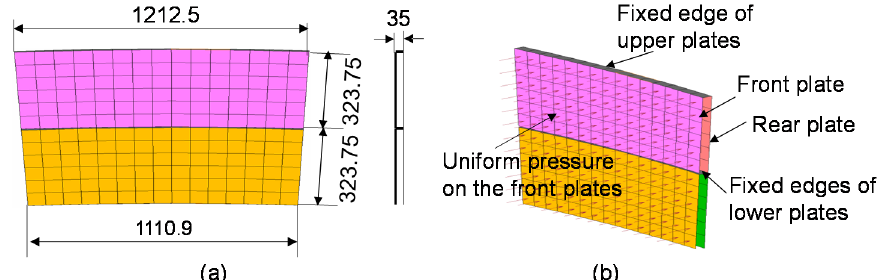
Figure 7. Self-adaptive flange model used in the structure analysis: ( a ) front view and dimensions; ( b ) 3-dimensional view and loading and boundary conditions.